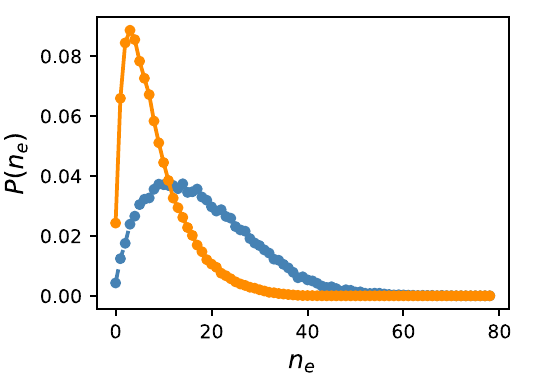
. The data for f 2 [0.99, 1.0] are shown. An edge is e